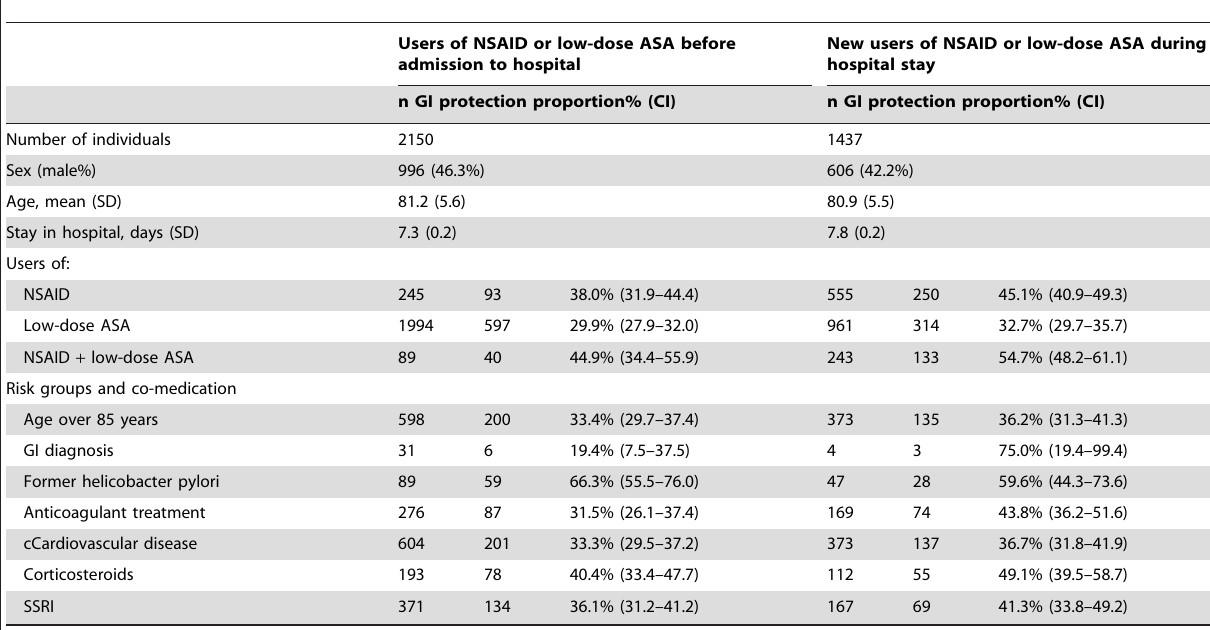
Table 1. Prevalence rate of concurrent use of GI protection for users of NSAIDs or low-dose ASA before hospital admission, and for new patients starting NSAID or low-dose ASA during hospital stay.